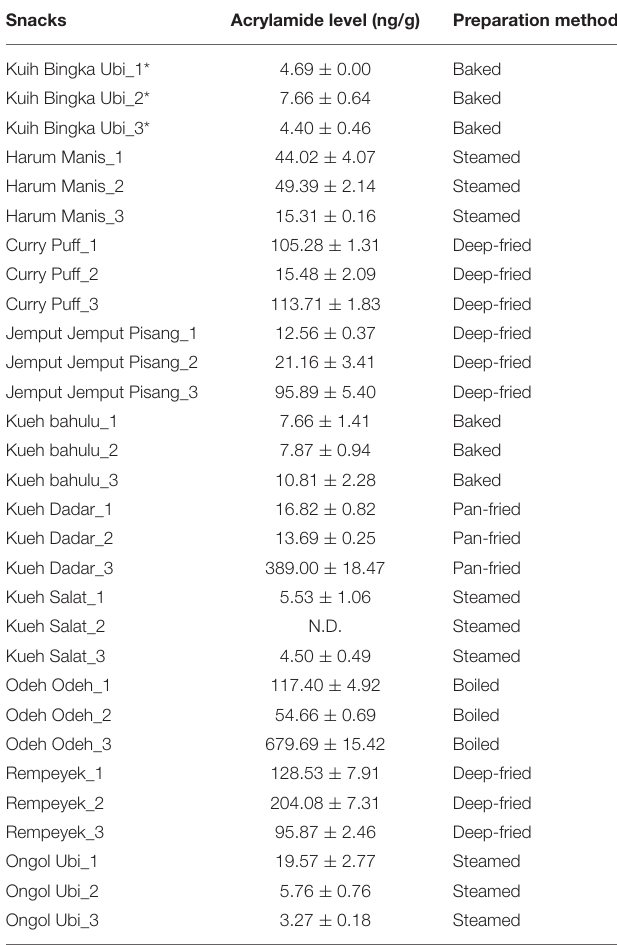
TABLE 2 | Acrylamide levels (ng/g) in commonly consumed local Malay snacks with three replicates.